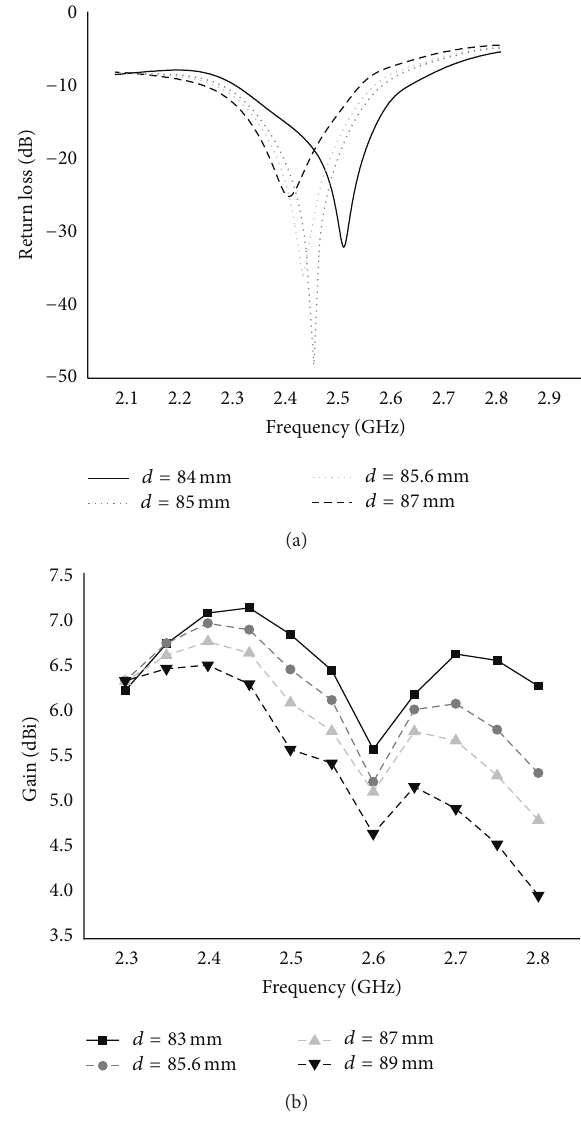
Figure 4: Array distance 𝑑 effect on simulated return loss and simulatedgainoffour-elementarrayswithoutadditionalground.(a) 𝑑 effect on simulated return loss and (b) 𝑑 effect on simulated gain. antenna resonant frequency. Figure 4(a) shows the simulated return loss and Figure 4(b) shows the simulated gain for different array distance 𝑑 values with other parameters